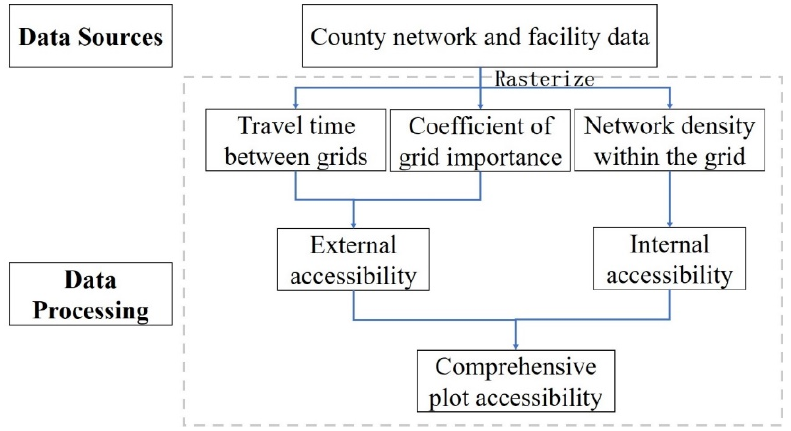
Figure 1. Flow chart of grid accessibility estimation.